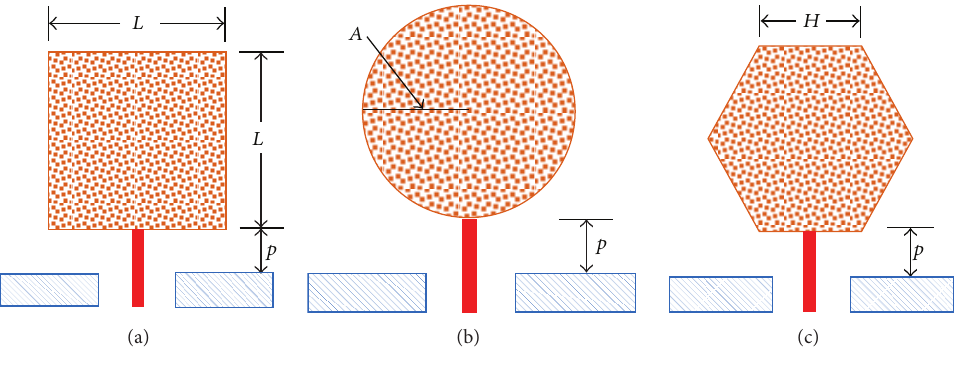
Figure 2: Geometrical shapes of PSMA, PCMA, and